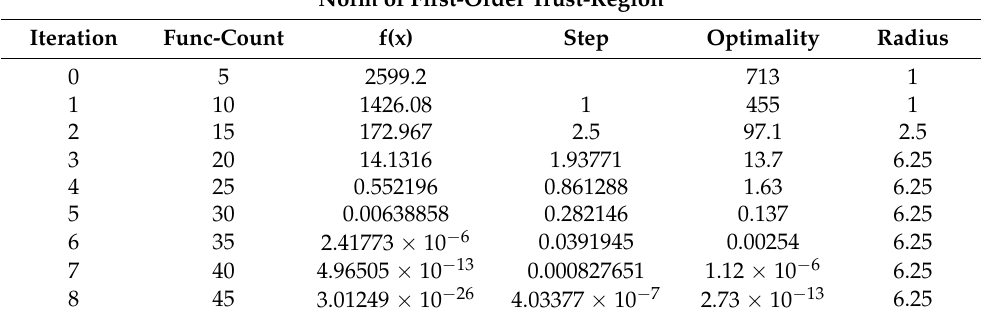
Table 1. Experiment